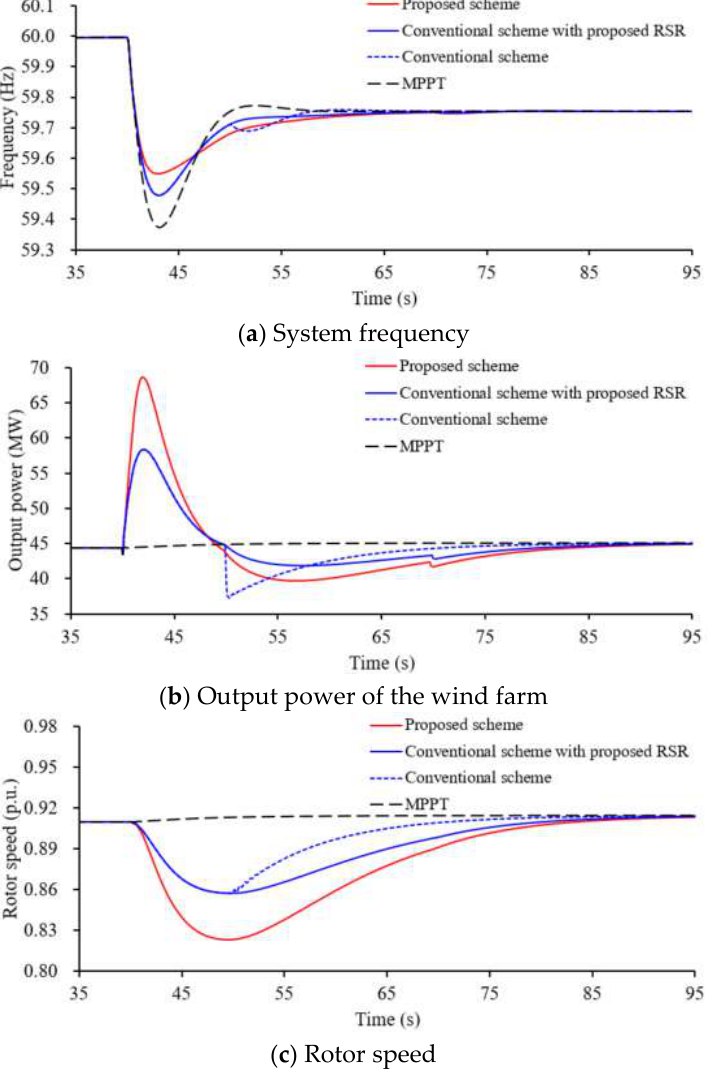
Figure 14. Results for Case 2.